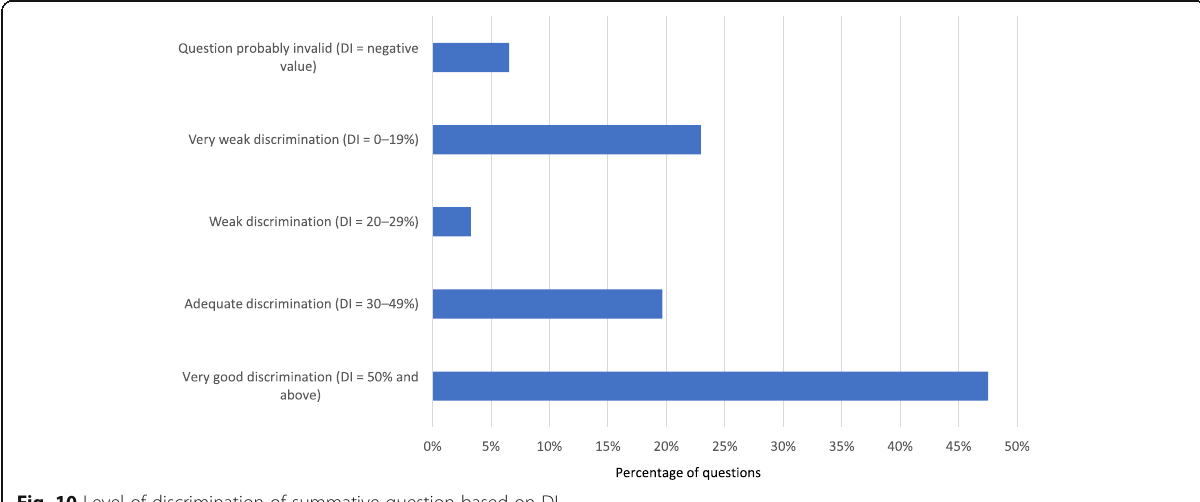
Fig. 10 Level of discrimination of summative question based on